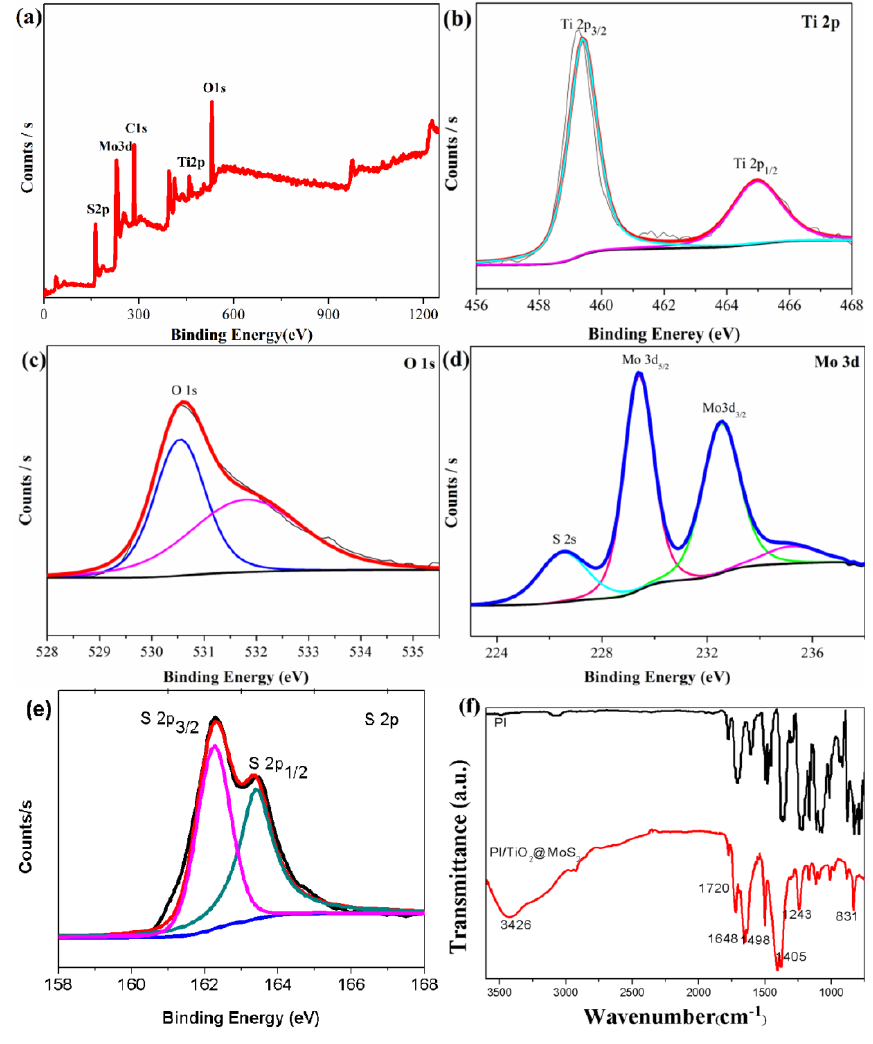
Figure 6. ( a ) XPS spectrum of PI/TiO 2 @MoS 2 composite; ( b – e ) high-resolution XPS spectra of Ti2p, O1s, Mo3d, and S2p; ( f ) FT-IR spectra of the